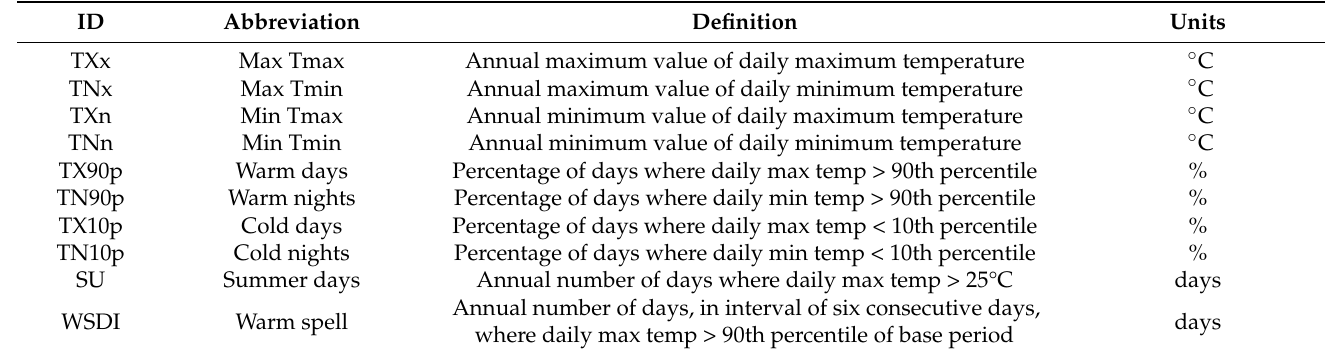
Table 2. Names, abbreviations, definitions, and units of climate indices used in the